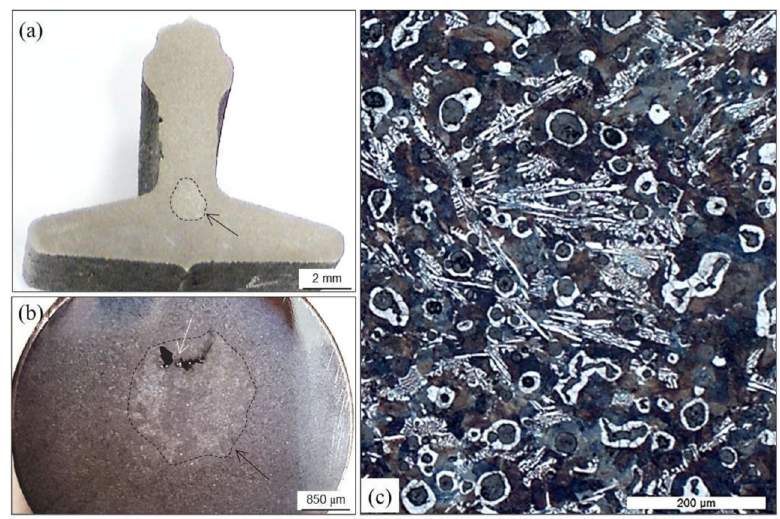
Figure 90. Inverse chill defects found in two different small section ductile iron castings ( a , b ). Microstructure found in the inverse chill areas ( c